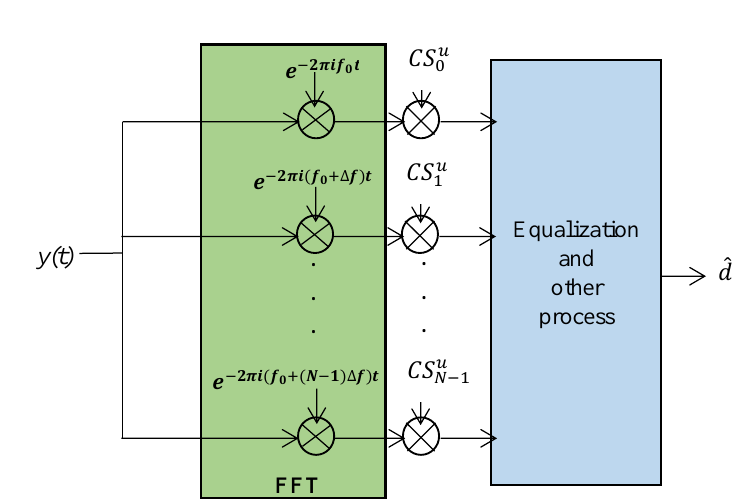
Figure 2. MC-CDMA